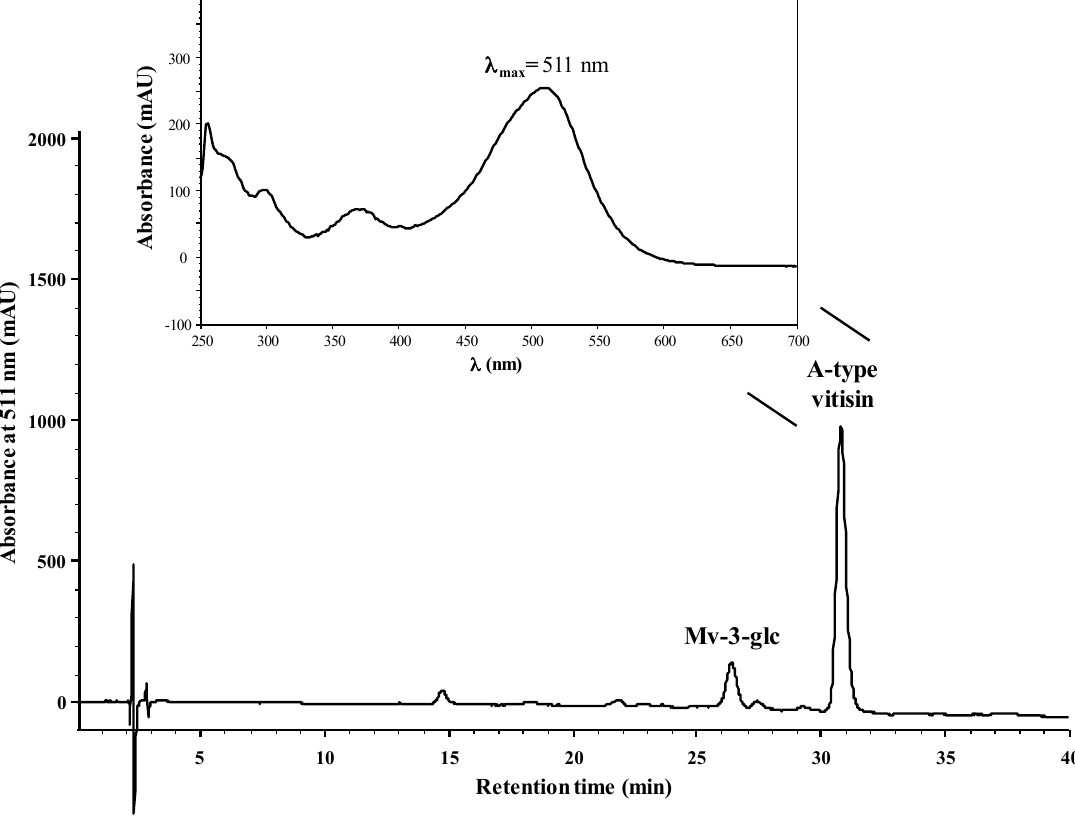
Figure 2. HPLC chromatogram recorded at 511 nm of a model solution containing mv-3-glc and OAA at pH 3.5 after 1 day of reaction at room temperature. Insert: UV-Visible spectrum and maximum absorption wavelength (511 nm) of the A-type vitisin recorded from the HPLC diode array detector. Table 1. Yields (%) of reaction for the synthesis of A-type vitisin from the reaction of mv-3-glc with oxaloacetic acid (OAA) or pyruvic acid (PA) at different pH values after 7 days of reaction at room temperature. Values with different letters are statistically different ( p < 0.05). Organic